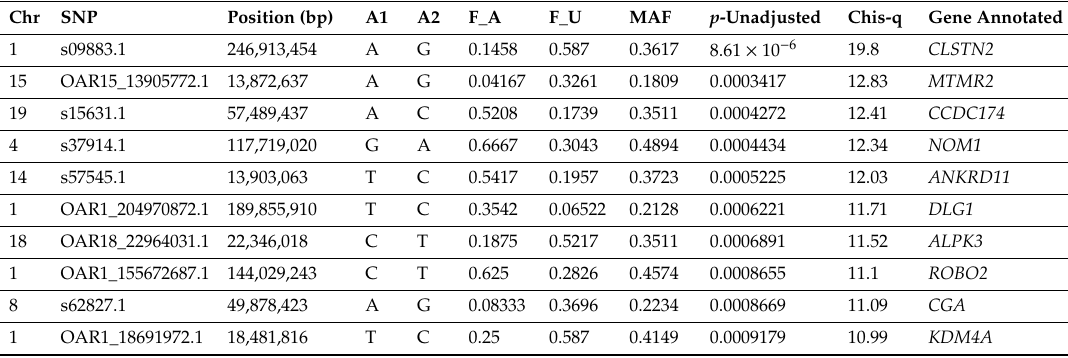
Table 2. The SNPs identified by GWAS for prolificacy in Pelibuey